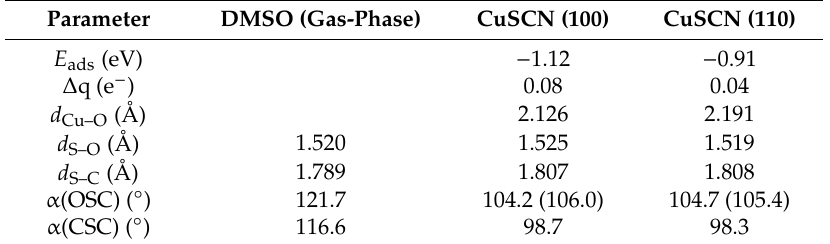
Figure 6. Lowest-energy DMSO adsorption geometry on ( a ) (100) and ( b ) (110) β -CuSCN surfaces. The corresponding di ff erential charge density iso-surface contours are shown in ( c ) for (100) and( d )for(110)surface. Iso-surfacecontourcolour: electrondensityaccumulation(green)anddepletion (red) by 0.02 e / Å 3 . Atomic colour: brown = Cu, grey = C, blue = N, and yellow = S. Table 3. Calculated adsorption energies ( E ads ), charge transfer ( ∆ q), and representative interatomic distances of the DSMO adsorption complex on β -CuSCN (100) and (110)